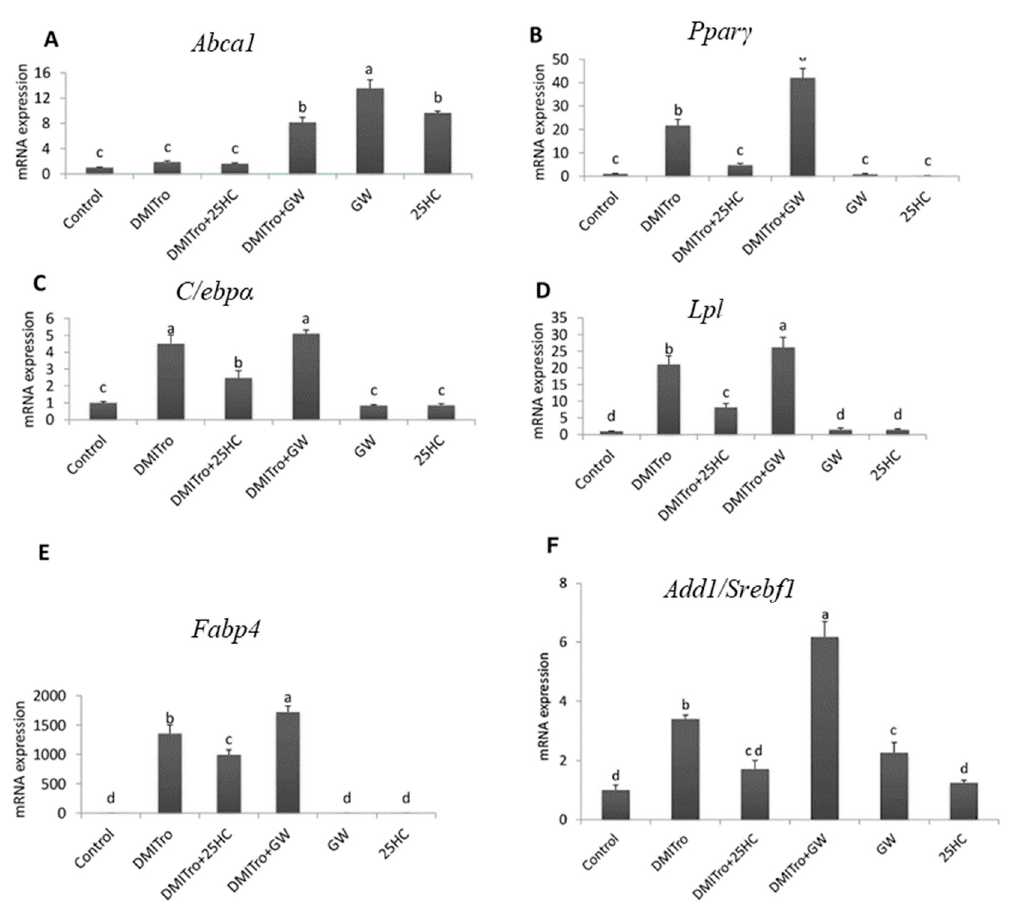
Figure 10. The e ff ect of liver X receptor agonist, GW3965, on the expression of Abca1 ( A ), Ppar γ ( B ), C / ebp α ( C ), Lpl ( D ), Fabp4 ( E ), and Add1 / Srebf1 ( F ). C3H10T1 / 2 cells at confluence were treated control, 2 µ M GW3965 or 10 µ M 25-HC, with or without DMITro, for 96 h. The results show the average values of three replicates ( n = 3) and the SD of the means. Bars with the same letter are not significantly di ff